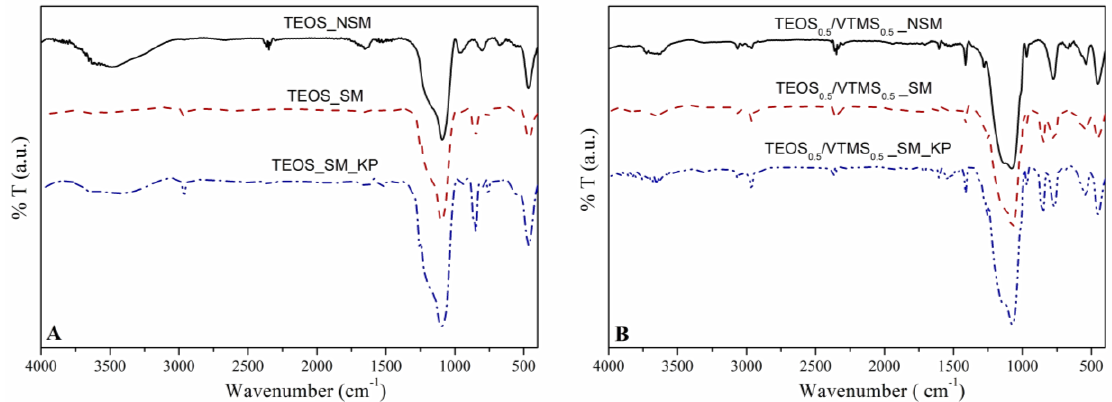
Figure 3. FTIR spectra before (NSM) and after surface modification (SM), and after adding fibers (KP), for ( A ) TEOS and ( B ) TEOS 0.5 / VTMS 0.5 samples.